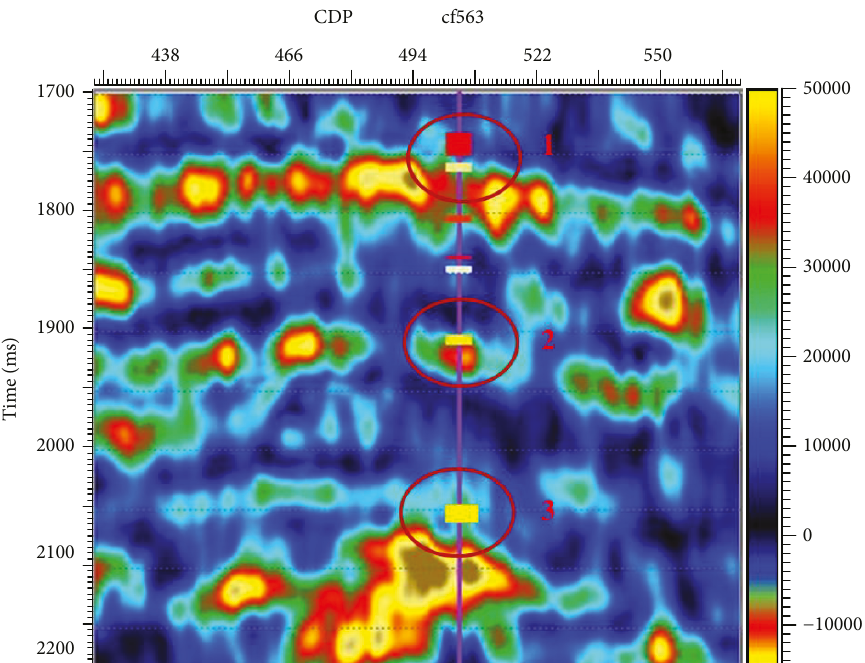
Figure 11: The inversion pro fi le through well cf563 by Wilson ’ s scheme. The prediction by Wilson ’ s scheme matches the well test at location 2. But at the locations 1 and 3, the values of P-wave dispersion gradient are not high while they are good conventional and fractured gas reservoirs. The predictions by Wilson ’ s scheme mismatch with well tests at the two Figure 10 is the slice of P – wave ’ s dispersion gradient along the fi rst set sand which is near the bottom of T x 4 3 member. Inversion results show that the west and the south- east of the area is the favorable zone of gas reservoirs for the high value of P-wave dispersion gradient.